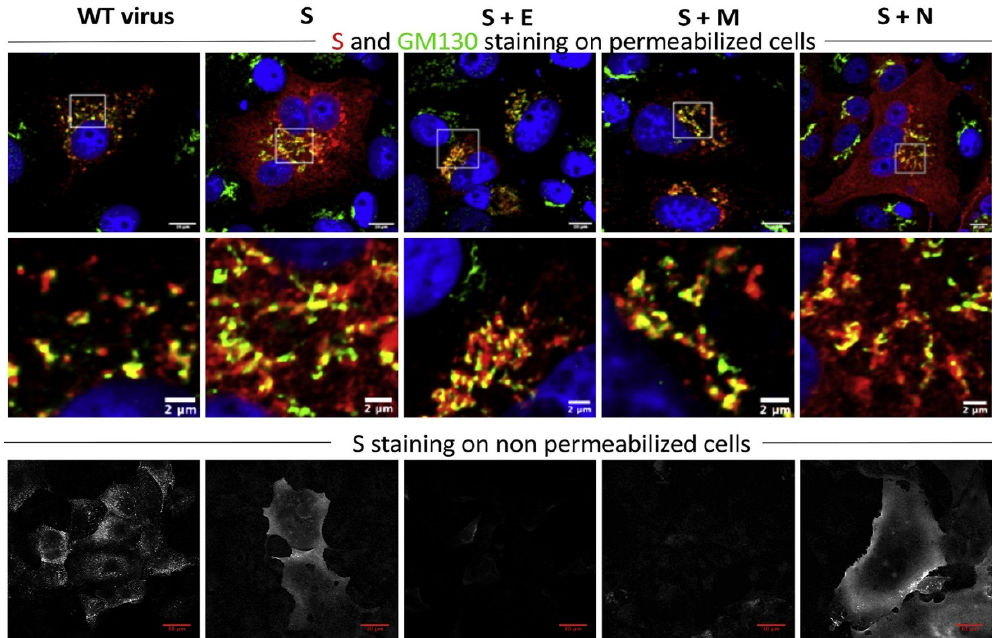
Figure 3. Studying intracellular distribution of spike protein by immunocytochemistry and confocal microscopy. Cells were either infected with SARS-CoV-2 (left column) or transfected with plasmids encoding S, E, M and/or N proteins as indicated at the top. GM130 (green) was used as a cis-Golgi marker. Note that S protein (red in the top panels or white in the bottom panels) are exported on the plasma membrane when expressed alone or with N protein, but it retains into intracellular vesicles when coexpressed with M or E proteins. Images from Boson et al. [36].